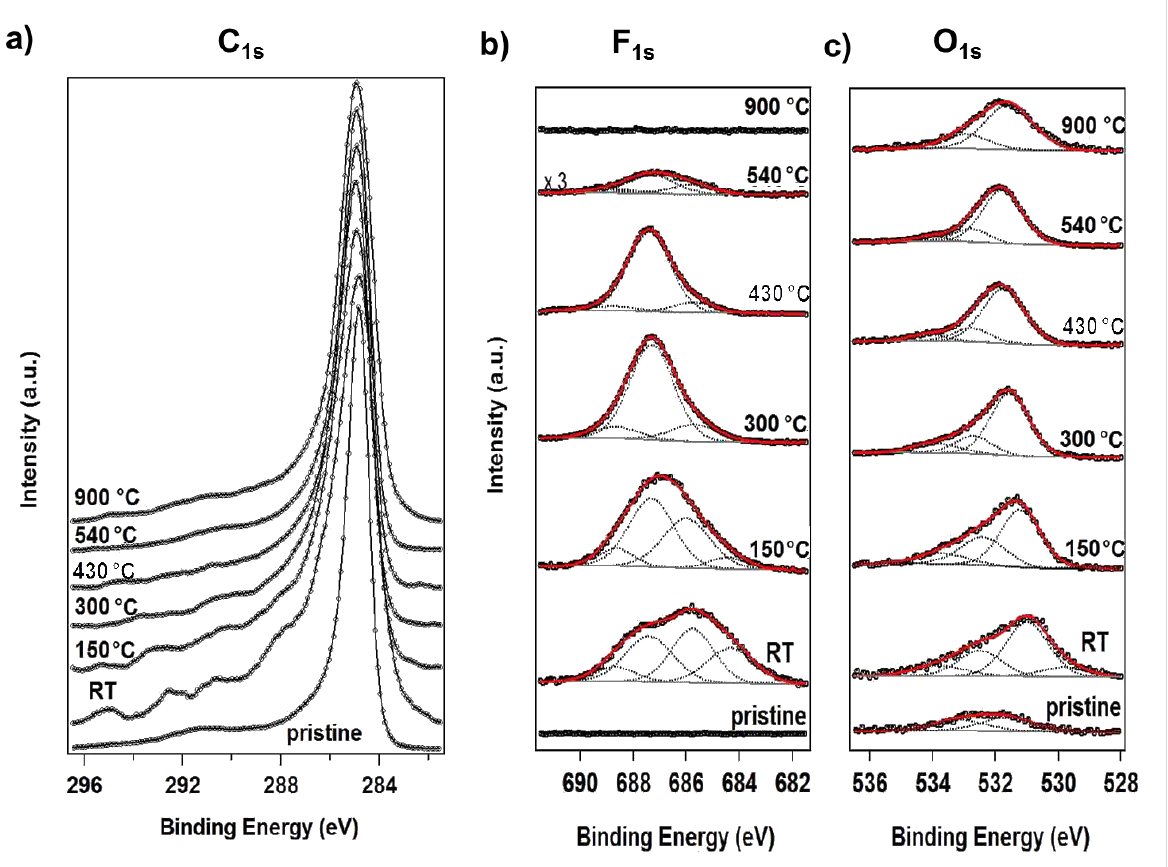
Figure 1: Temperature-dependent XPS analysis of functionalized vCNTs. (a) C 1s spectra acquired as a function of heating temperature. The C 1s spectrum recorded just after the fluorination is labelled RT, the pristine spectrum is the bottom curve. The spectra were normalized and stacked for better visualization of changes in their lineshape. (b,c) Fitting curves of the experimental data (black dots) acquired from F 1s and O 1s core levels as a function of heating